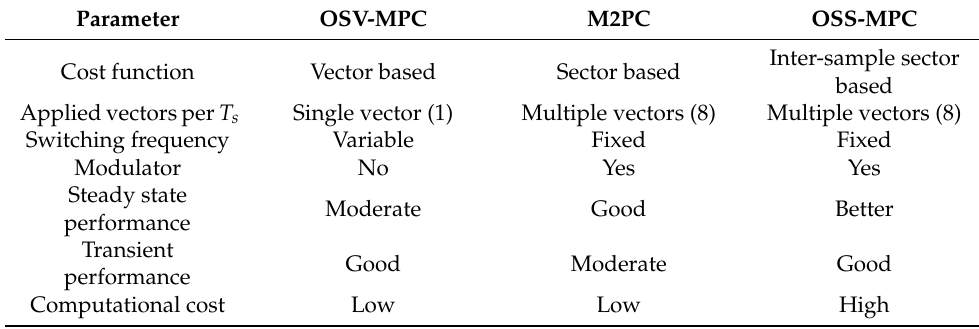
Table 6. Comparison between OSV-MPC, M2PC, and OSS-MPC. Parameter OSV-MPC M2PC OSS-MPC Inter-sample sector Cost function Vector based Sector based based Applied vectors per T s Single vector (1) Multiple vectors (8) Multiple vectors (8) Switching frequency Variable Fixed Fixed Modulator No Yes Moderate Good Better Good Moderate Good Low Low